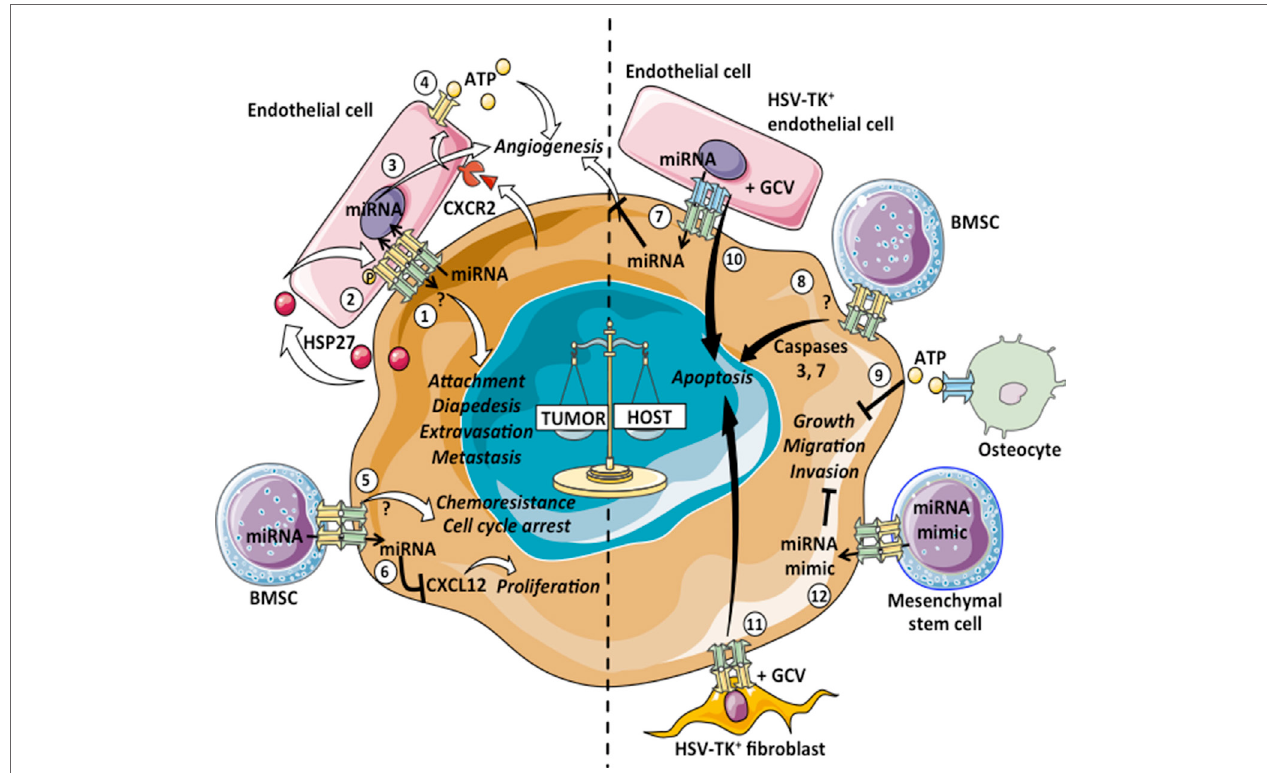
FiGURe 2 | Pro- and antitumoral effects of tumor–stromal non-immune cell heterotypic GJICs. Gap junction (GJ)-mediated communications among tumor cells and normal non-immune cells can lead to pro-tumoral (left: 1–6) or antitumoral (right: 7–12) consequences. 1: intercellular communications mediated by Cx26- and Cx43-GJs among melanoma or breast cancer cells with endothelial cells promote cell attachment, diapedesis, extravasation and metastasis of tumor cells. 2: primary colon cancer cells release heat-shock protein 27 (HSP27), which induces the phosphorylation of Cx43 in endothelial cells and the subsequent formation of heterotypic GJs with tumor cells. This communication thus promotes transendothelial migration of primary colon cancer cells. 3: the GJ-mediated transfer of microRNAs (miRNAs) from glioblastoma cells to endothelial cells promotes angiogenesis. 4: metastatic colon cancer cells induce Cx32-HCs in endothelial cells via CXCR2. The adenosine triphosphate (ATP) released by Cx32-HCs could induce neo-angiogenesis in the metastatic foci. 5: leukemic cells GJ-coupled with bone marrow stromal cells (BMSCs) are arrested in G0 and acquire resistance to chemotherapy-induced apoptosis. 6: breast cancer cells acquired CXCL12-specific miRNAs from BMSCs via GJs, which induce cancer cell dormancy. 7: Cx43-GJ-mediated transfer of antitumoral miRNAs from human microvascular endothelial cells to colon cancer cells inhibits the angiogenesis induced by the cancer cells. 8: BMSCs overexpressing Cx43 form functional GJ with T lymphoblastic leukemia cells and increase the basal level of apoptosis due to the Cx43-dependent activation of caspases 3 and 7. 9: the ATP released through Cx43-HCs by osteocytes inhibits anchorage-independent growth, migration and invasion properties of human and mouse breast cancer cells. 10, 11: when herpes virus thymidine kinase (HSV-TK) + endothelial cells or fibroblasts are cocultured with different tumor cell lines in the presence of ganciclovir (GCV), the extent of bystander killing correlates with the level of GJ communication between the tumor and HSV-TK + cells. 12: mesenchymal stem cells deliver synthetic miRNA mimics to glioma and glioma stem cells via GJs, decreasing migration and self-renewal of tumor